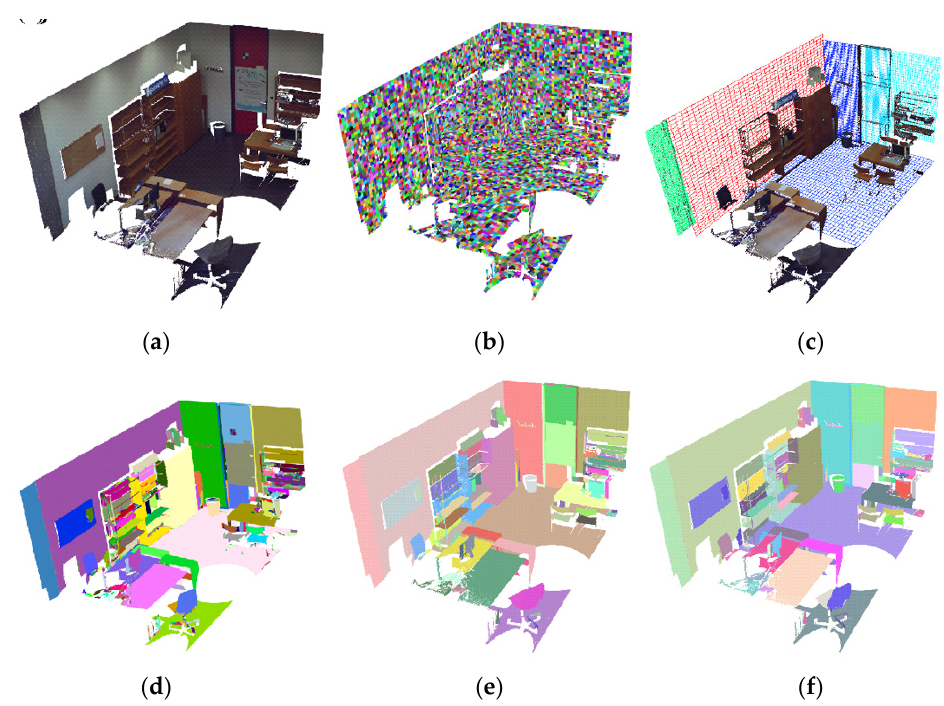
Figure 8. The segmentation result of Room-L80. ( a ) Raw point clouds ( b ) The generated surface patches. ( c ) The extracted indoor structural planes set and leftover points of the scene. ( d ) The indoor segmentations after multi-constraint graph clustering. ( e ) The final segmentation result after post-refinement. ( f ) The ground truth. Table 1. Descriptions of the data.